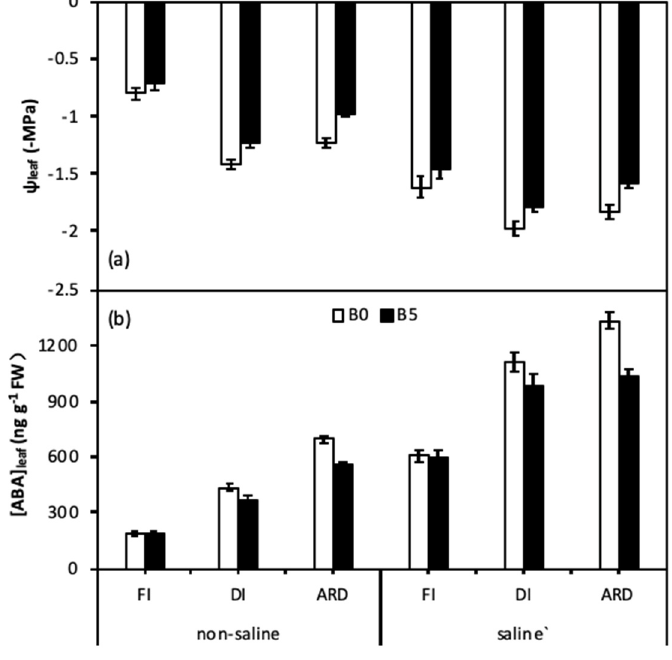
Figure 2. Total leaf water potential ( Ψ leaf ) ( a ) and abscisic acid (ABA) concentrations ( b ) of quinoa leaves as affected by biochar, irrigation regimes, and salinity. B0 and B5 indicate biochar levels, respectively. FI, DI, and ARD indicate full irrigation, deficit irrigation, and alternate root-zone drying irrigation, respectively. Error bars indicate ±SE ( n = 4). SE indicates standard error.